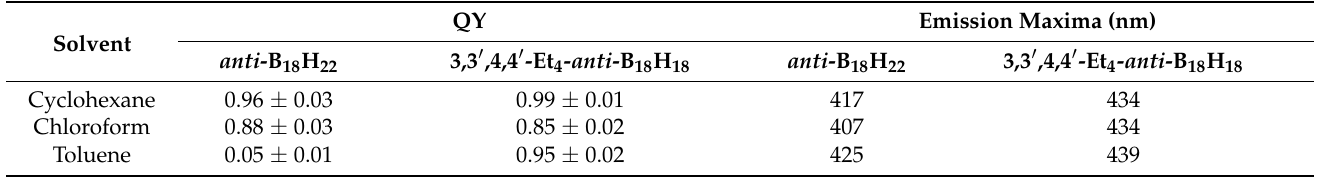
Table 2. QY of borane compounds in different